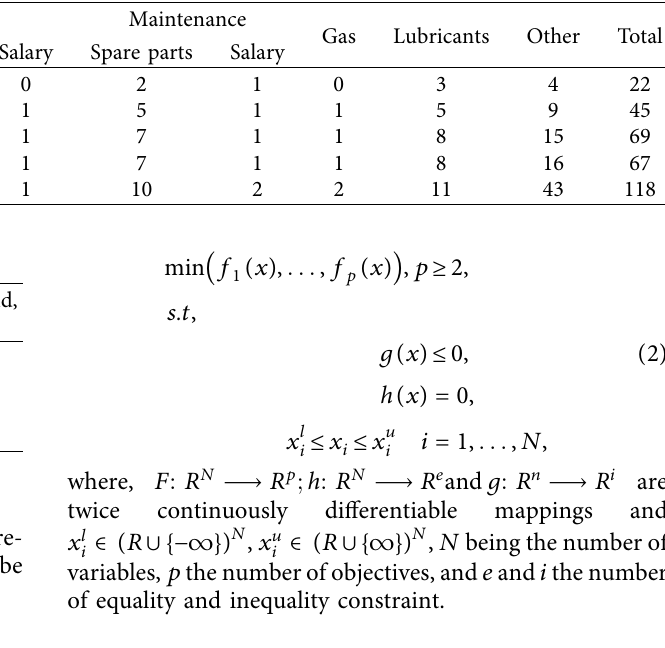
Figure 1: The conceptual model of the haulage system at sarcheshmeh copper Table 2: Hourly operating cost of trucks (cost unit) [1].